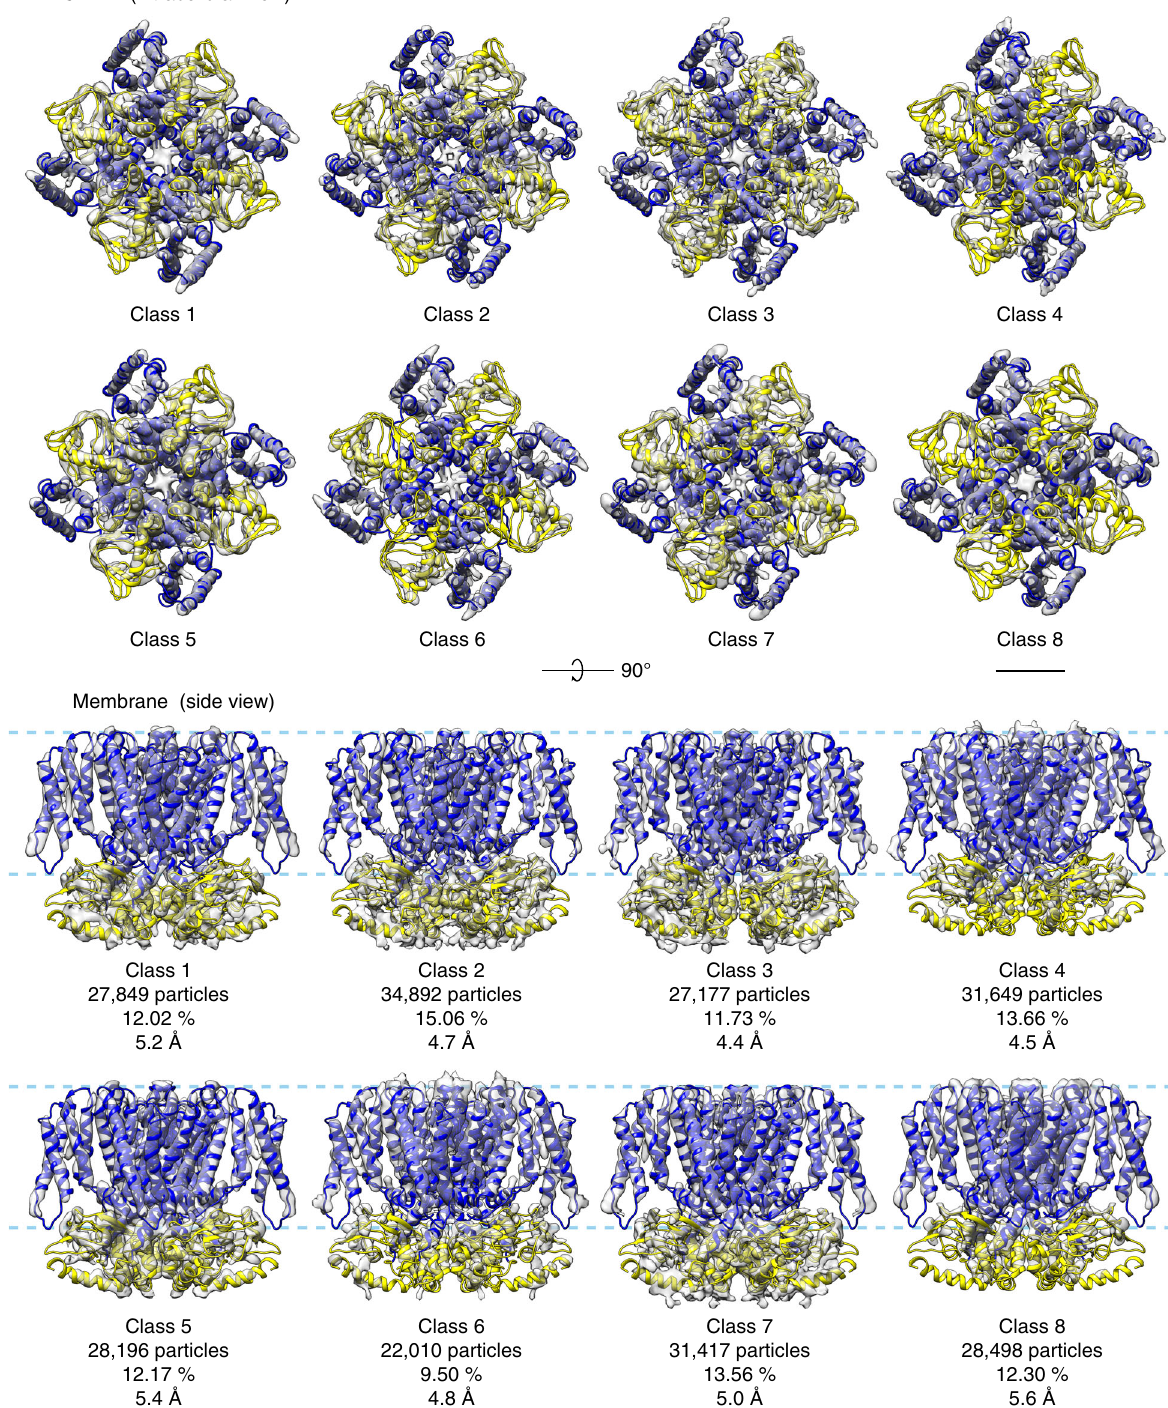
Fig. 3 Conformational continuum of MloK1 from 2D crystals. All the maps were obtained from one 2D crystal dataset using signal subtraction and 3D classi fi cation after consensus re fi nement. The consensus model was fl exibly fi tted and re fi ned into each 3D class. The CNBD is colored yellow and the TMD is colored blue, while the maps are shown as transparent gray surfaces. The map threshold for each class was calculated such that all iso-surfaces enclose the same volume. The pale blue dashed line indicates the approximate position of the lipid bilayer. Conformational variations among the classes primarily change the height of the CNBDs in relation to the membrane slab and their tilt in relation to the TMD and the VSD. C4 symmetry was applied. Scale bar: 25